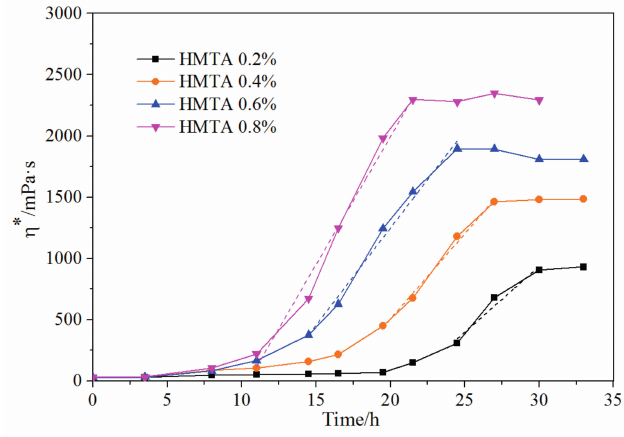
Figure 9. Effect of HMTA concentration on crosslinking reaction process of the polymer gel.